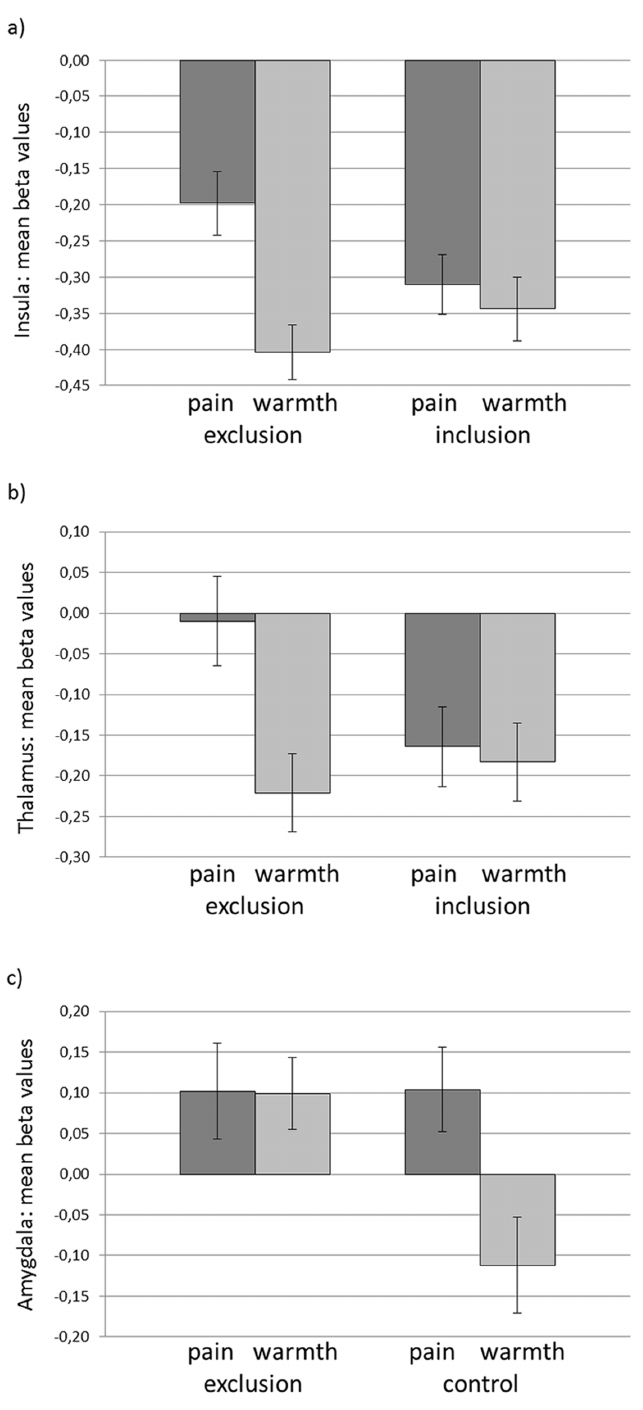
Fig 1. Mean beta values of the comparison between pain (vs. warmth) after social exclusion compared to inclusion a) in left insula, b) in right thalamus and c) compared to the control condition in the right amygdala independent of